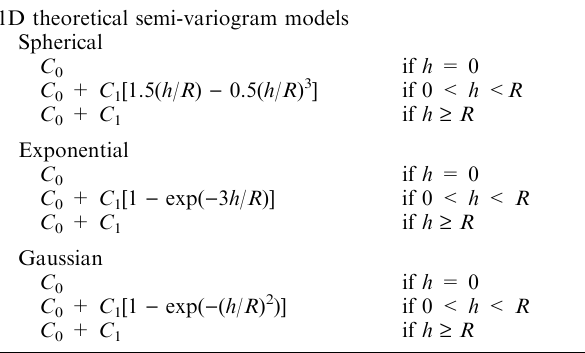
Table 2. Semi-variogram models 1D theoretical semi-variogram models